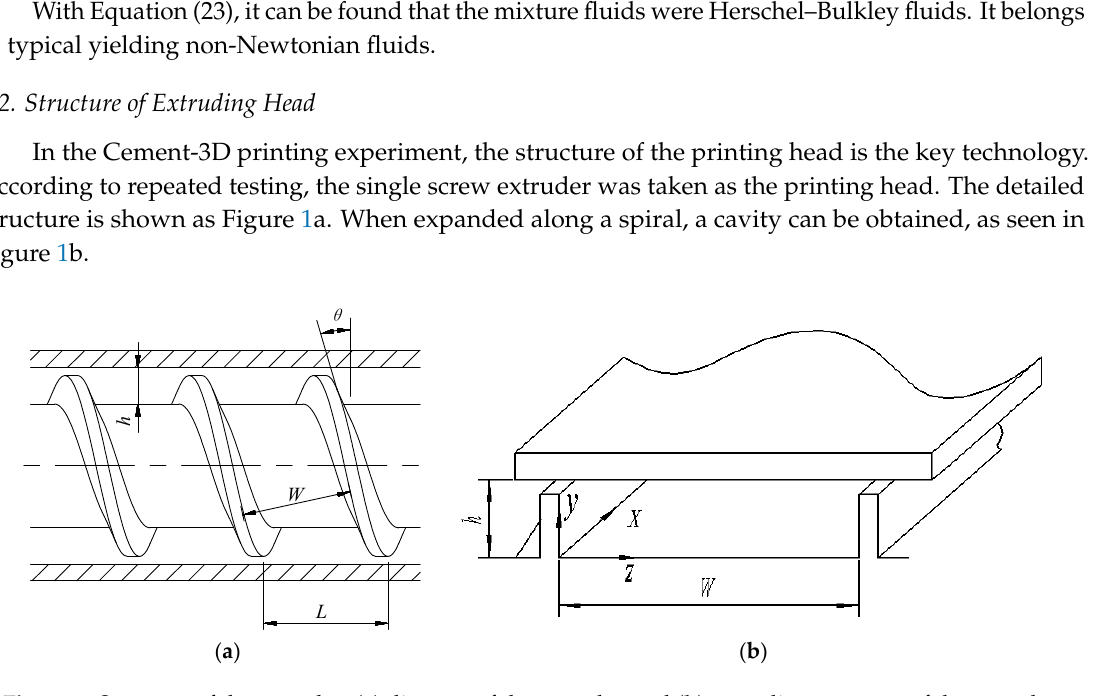
Figure 1. Structure of the extruder: ( a ) diagram of the extruder, and ( b ) spreading structure of the extruder. The specific meanings and values of the key parameters have been listed in Table